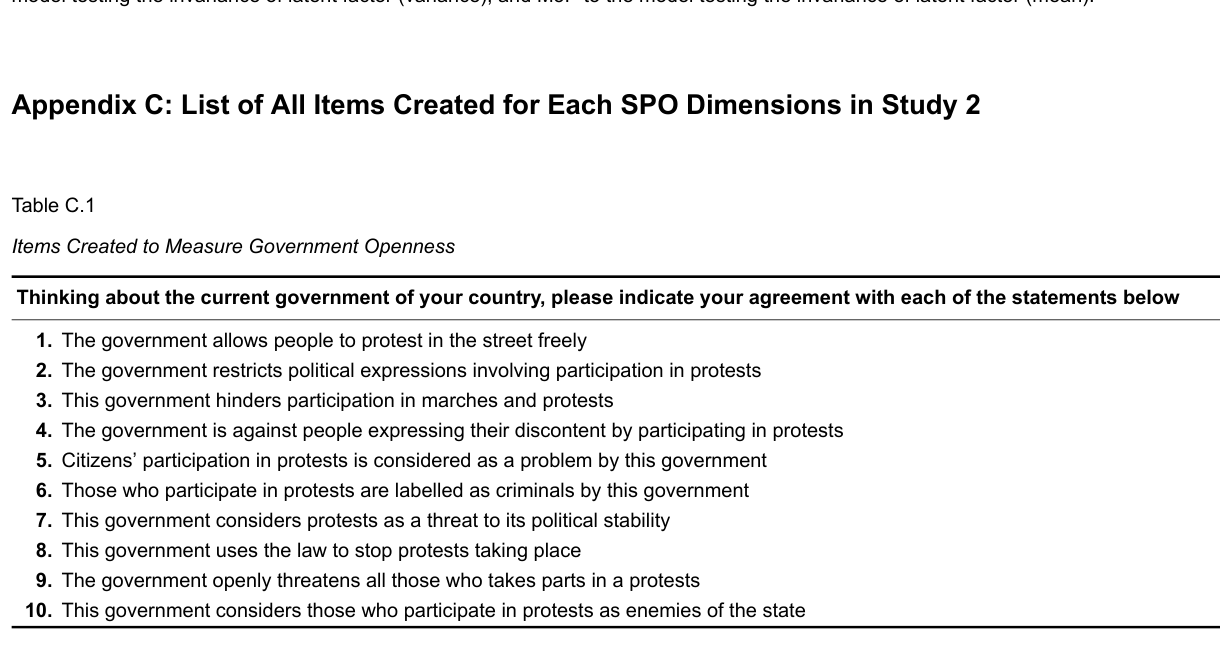
ModelComparison90% CI for RMSEA